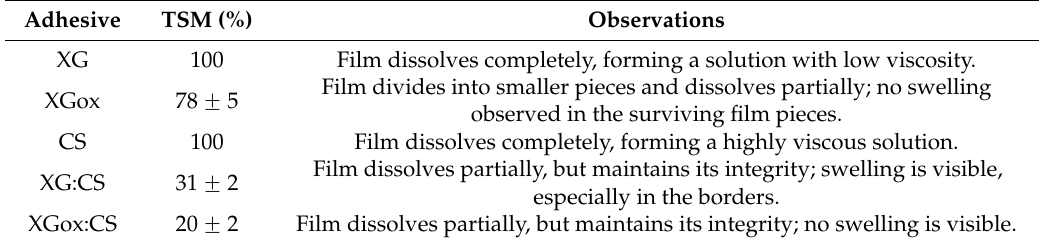
Table 2. Total soluble matter (TSM) and aspect observations of films of xanthan gum (XG), oxidized xanthan gum (XGox), chitosan (CS), and mixtures at 1:1 mass ratio. Standard deviation is for a minimum of three